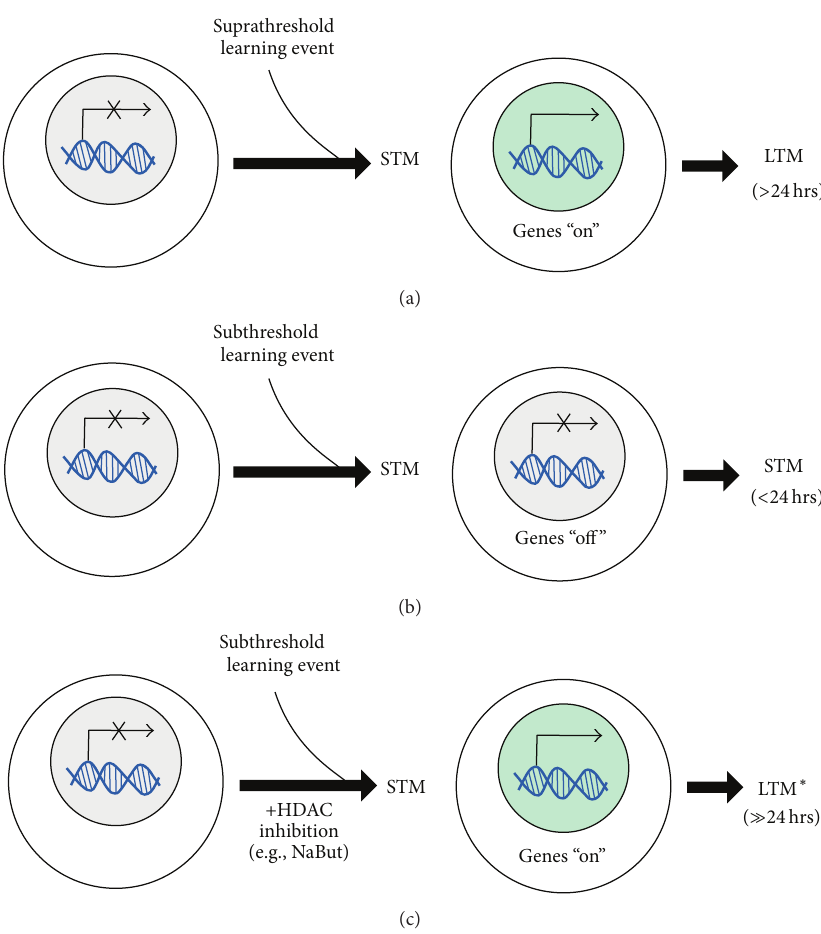
Figure 1: Long-term memory formation at the neuronal level. A mechanistic simplification of how behavioral epigenetics exert molecular control of gene expression for memory formation. (a) At a neuronal level, memory consolidation requires gene expression (genes “on”), which “suprathreshold” learning events can naturally activate to result in long-term memory (LTM: long-term memory, e.g., > 24 hrs). Note that this depiction is an oversimplification showing only the requirement for gene expression, however which genes are activated, the magnitude of their expression, and also the temporal dynamics of transient or sustained expression are also factors. Circles represent a single neuron